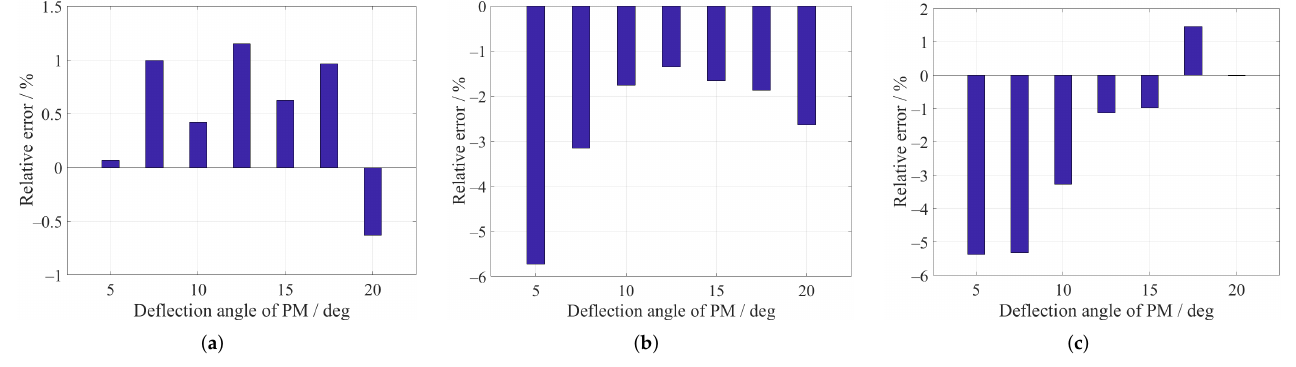
Figure 11. Relative errors of electromagnetic forces between the analytical and FEA methods. ( a ) Rel- ative error of levitation force; ( b ) Relative error of drag force; ( c ) Relative error of lateral force.